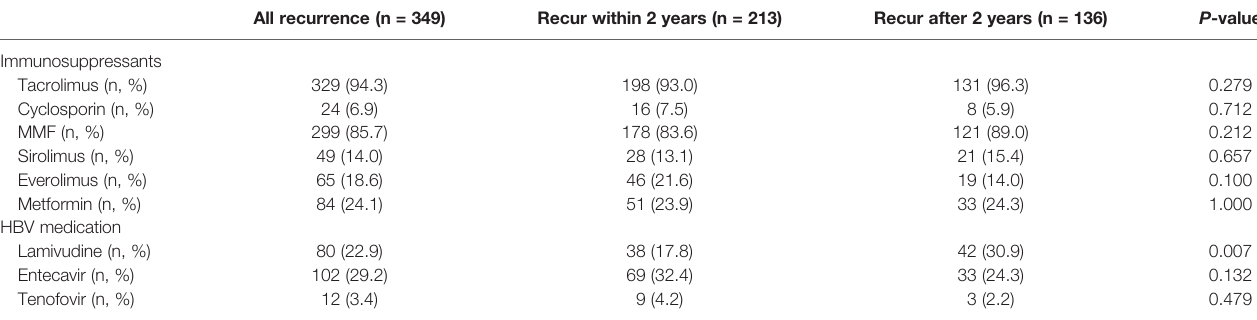
TABLE 2 | Summary of selective medications within 6 months after transplant. All recurrence (n =